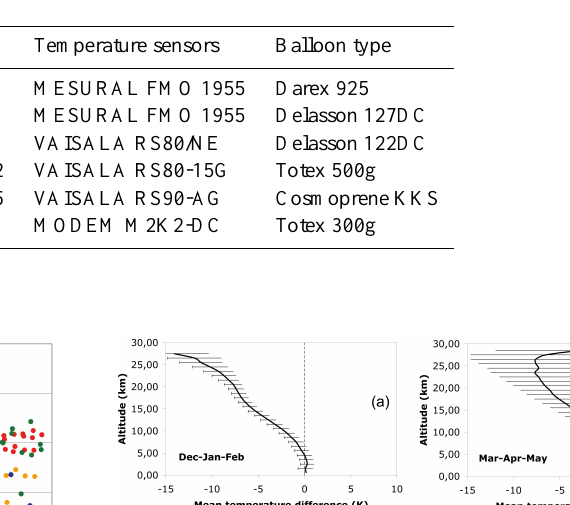
Table 1. Types of sondes and balloons used for temperature soundings at Dumont d’Urville between 1957 and 1962 and since 1979.